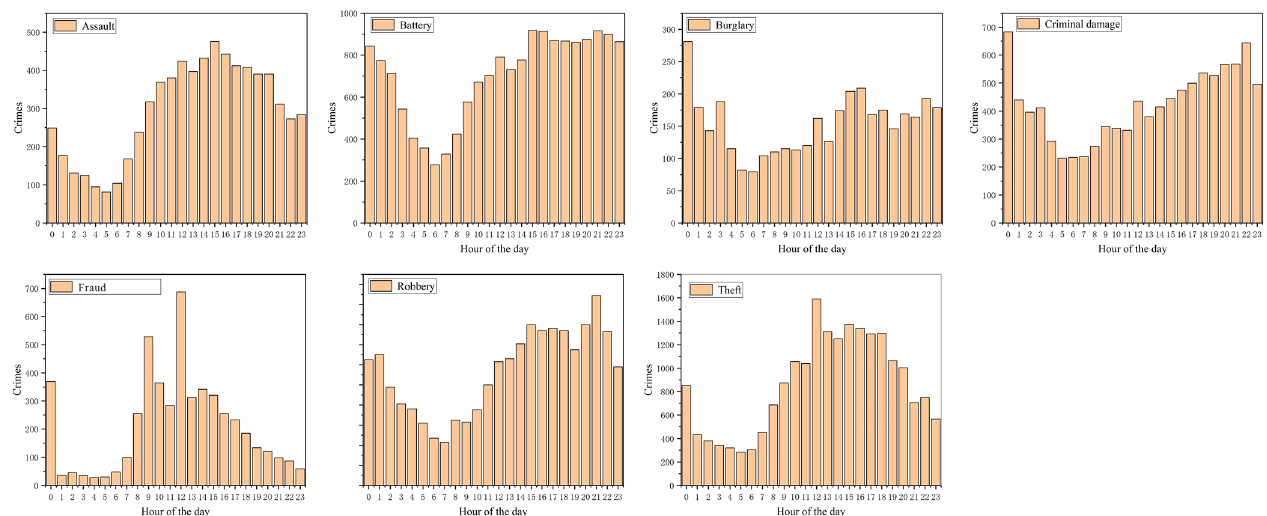
Figure 3. Temporal distributions (h) of different crimes, the number of crimes aggregated as hourly, from February to June in 2020. The ordinate represents the number of crimes, and the abscissa represents the hour of the day.